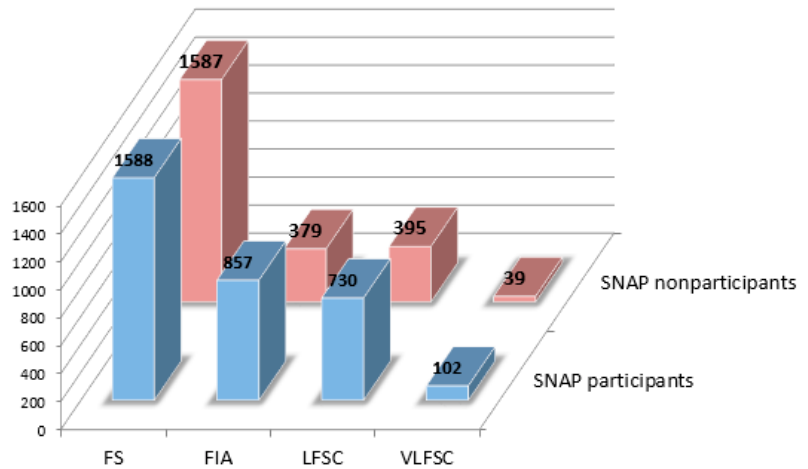
Figure 1. Frequency distribution of SNAP participation and food-insecure categories. FS: food-secure; FIA: food-insecure among adults only; LFSC: low food security among children; VLFSC: very low food security among children.